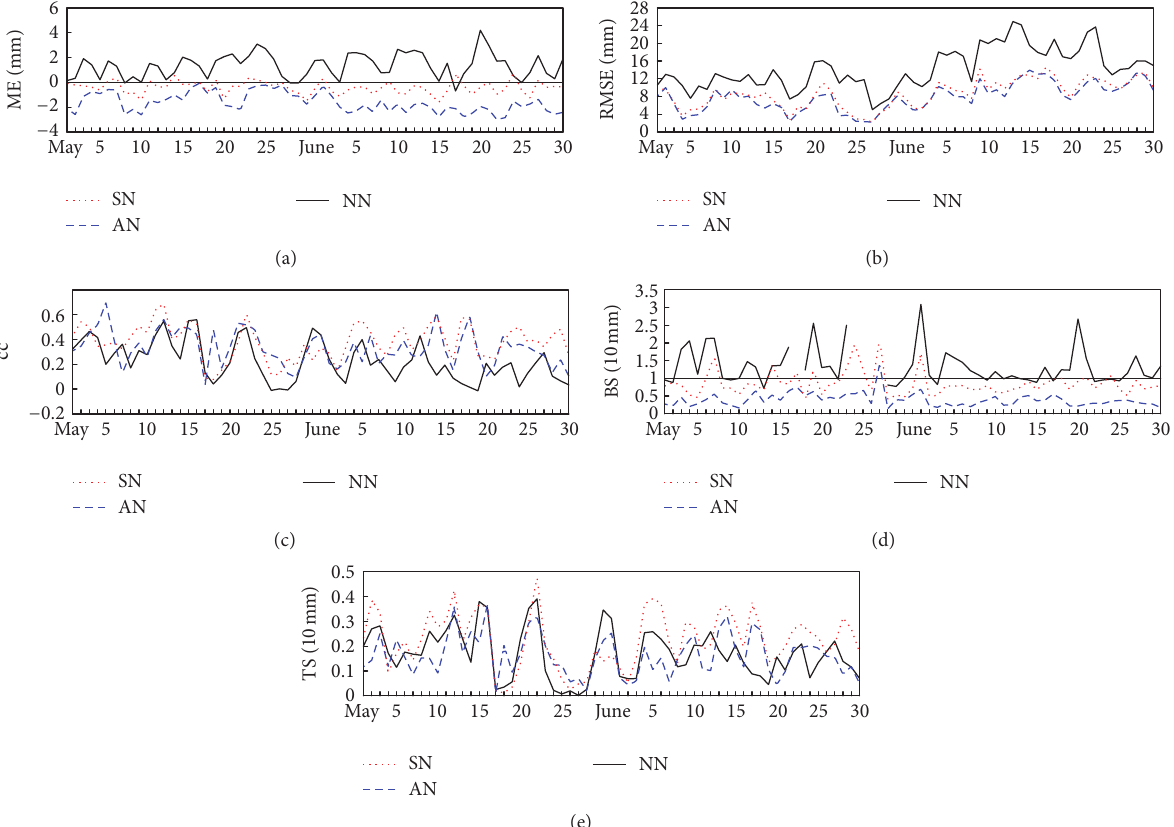
Figure 4: Time series plots of related statistical verification techniques for the daily accumulated precipitation in May and June 2011. (a) The ME between the observations and downscaling results by WRF by NN, AN and SN; (b) the same as (a), but is the RMSE; (c) the same as (a), but is the cc; (d) BS at the threshold of 10mm (if the BS value is greater than 3, we set it as a missing value because it indicates much overprediction of precipitation and makes it difficult to understand the plot); (e) TS at the of 10-threshold